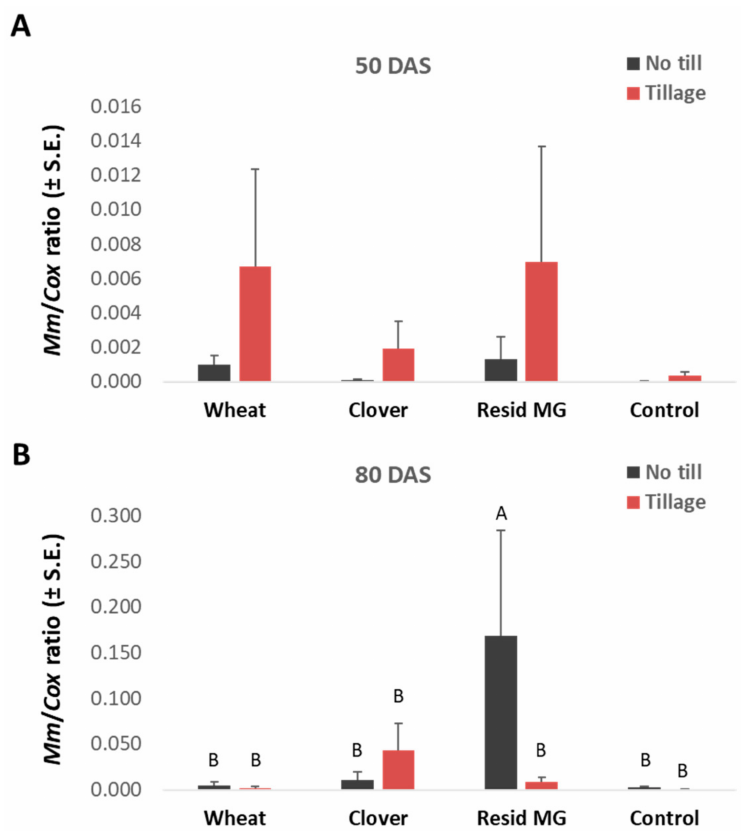
Figure 9. Field real-time PCR (qPCR) analysis measures of the pathogen DNA at 50 ( A ) and 80 ( B ) DAS in the plants’ roots and aboveground first internode, respectively. The experiment is described in Figure 2. The Y -axis represents the amount of DNA of the M. maydis pathogen relative to the total DNA in the plant tissue (represented by cytochrome c oxidase (COX) gene DNA present in the plant tissue and fungus cells. The values represent an average of five biological repetitions and error lines represent a standard error. Statistically significant differences (one-way ANOVA, p < 0.05) between treatments at the same measures (if they exist) are indicated by different letters (A,